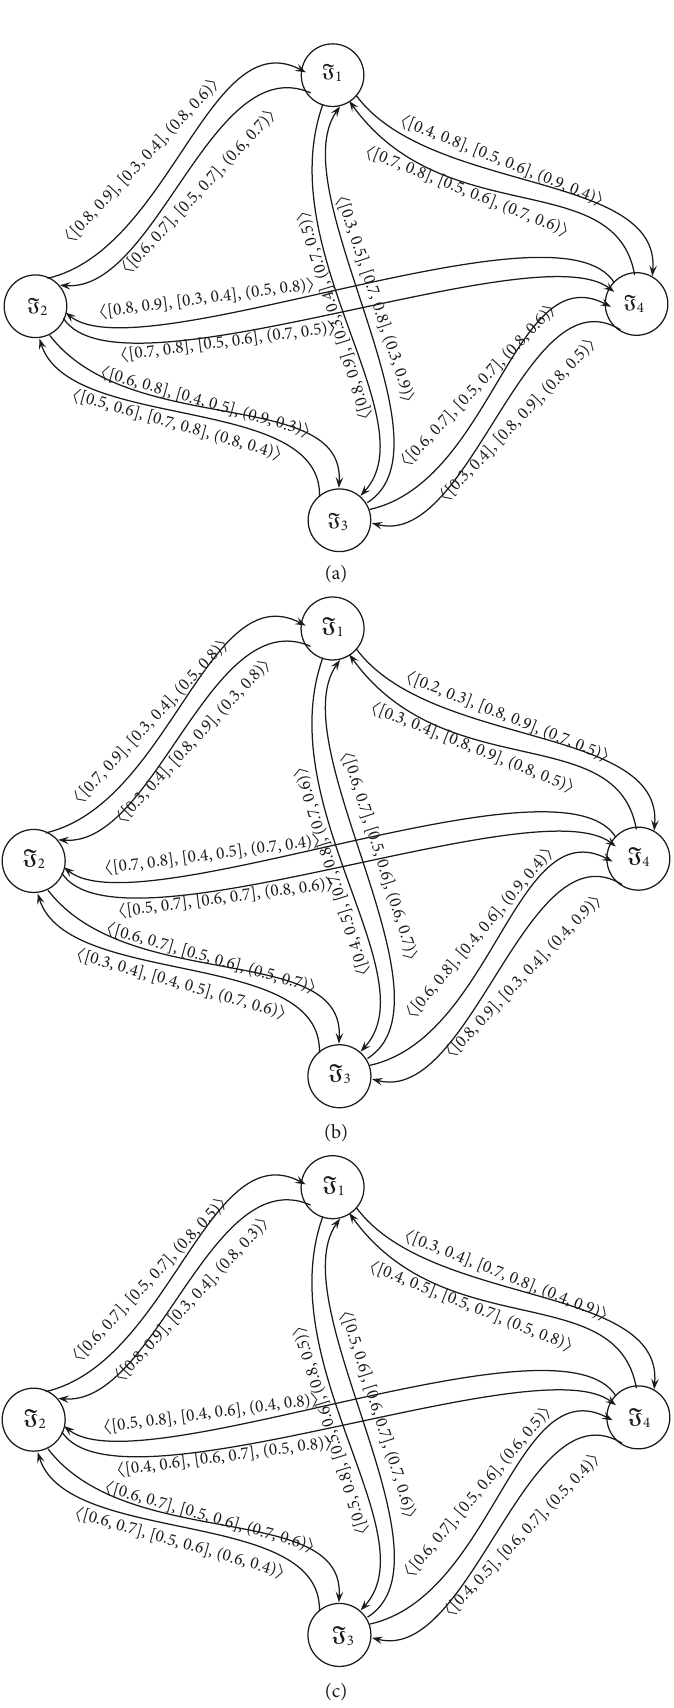
Figure 7: Cubic Pythagorean fuzzy influenced networks corresponding to